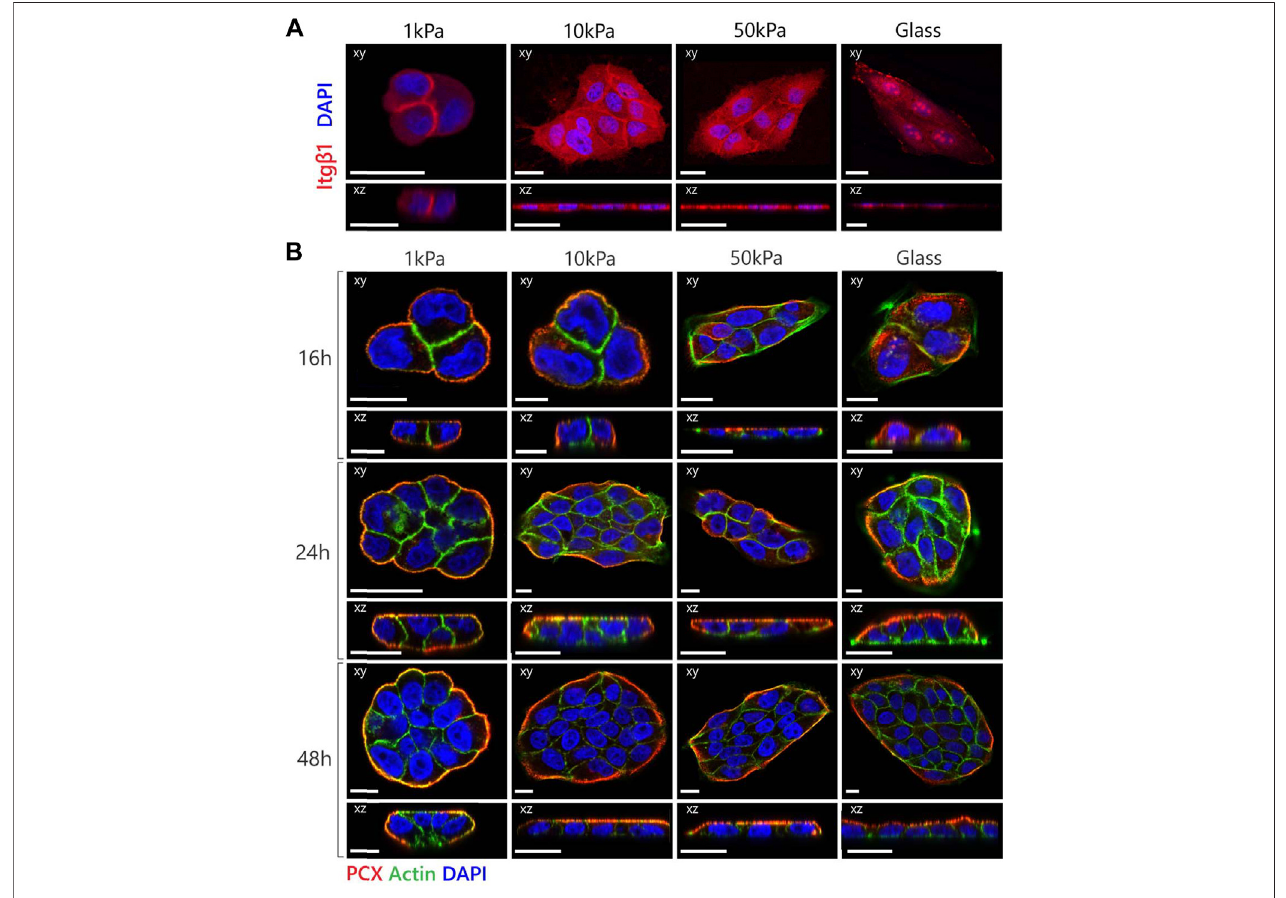
FIGURE 2 | MDCK polarization is dependent on expression as well as location of the β 1-integrin receptor. (A) Representative fl uorescent images of β 1-integrin expression in MDCKs cultured on substrates with variable elastic moduli. The cells were stained for β 1-integrin (red) and nucleus (blue). (B) Representative fl uorescent imagesofMDCKcellsculturedonsubstrateswithvariableelasticmoduliwiththeadditionofthe β 1-integrininhibitorAIIB2totheculturemediumina fi nalconcentrationof 2 µgmL − 1 .Thecellswerestainedforpodocalyxin(red),actin(green)andnuclei(blue).Confocalsectionsareshowninbothxy(top)andxz(bottom)direction.Scale bars are 20